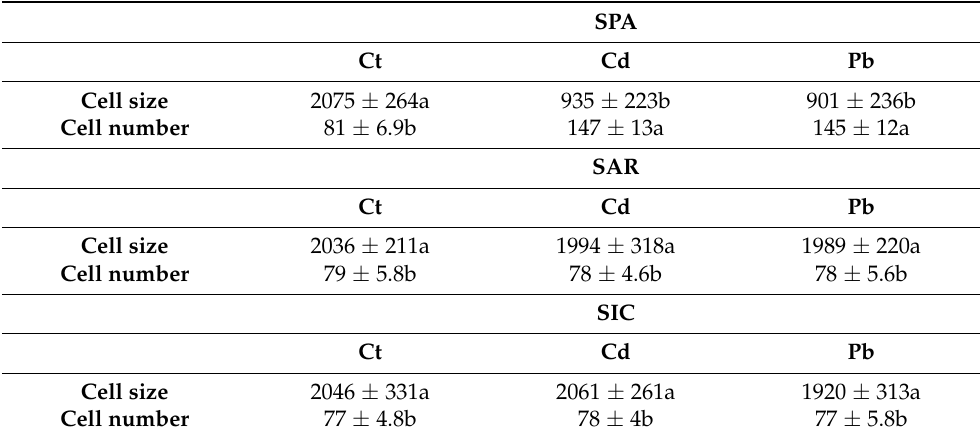
Table 2. Epidermal cell size (area, µ m 2 ) and cell number of C. cardunculus , cultivars Spagnolo (SPA), Sardo (SAR), and Siciliano (SIC) in control (Ct) and metal-treated samples (Cd and Pb); mean values ± standard deviations ( n =